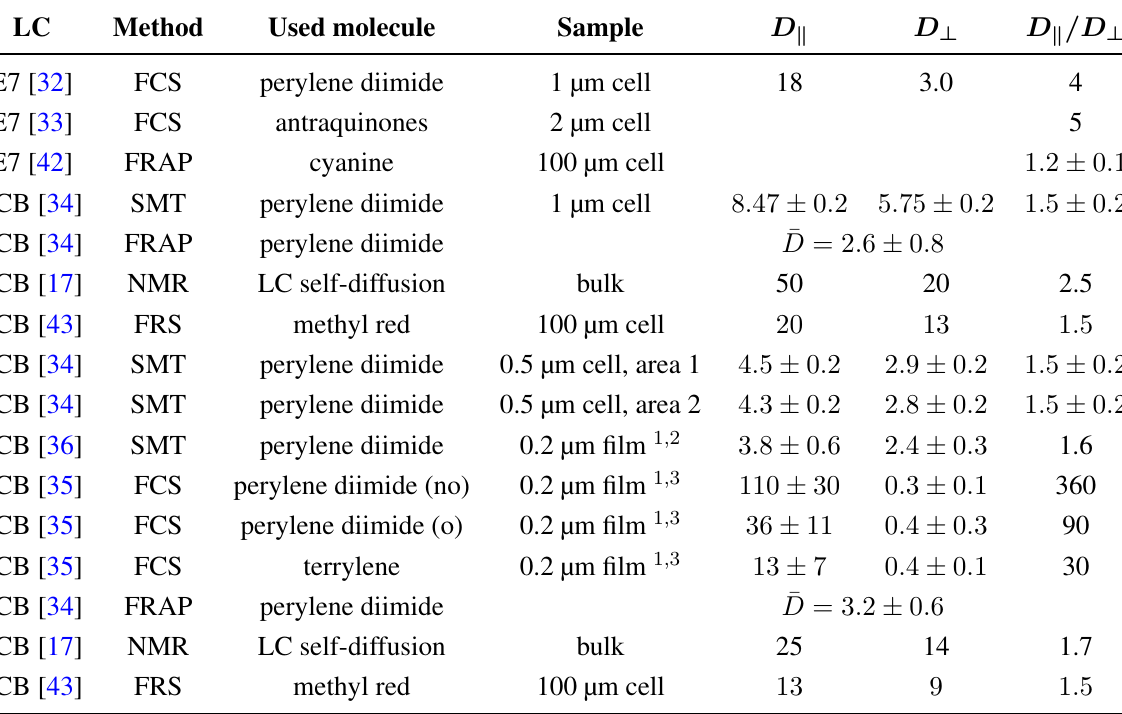
Table 1. Diffusion coefficients in µm 2 /s and diffusion anisotropy of small tracer molecules and of liquid crystal (LC) self-diffusion derived from different SM and ensemble methods at room